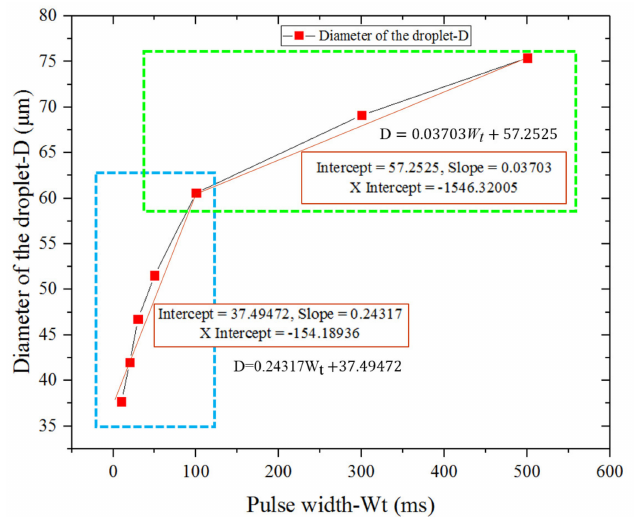
Figure 8. The approximate linear relation of droplet diameter versus pulse width in different